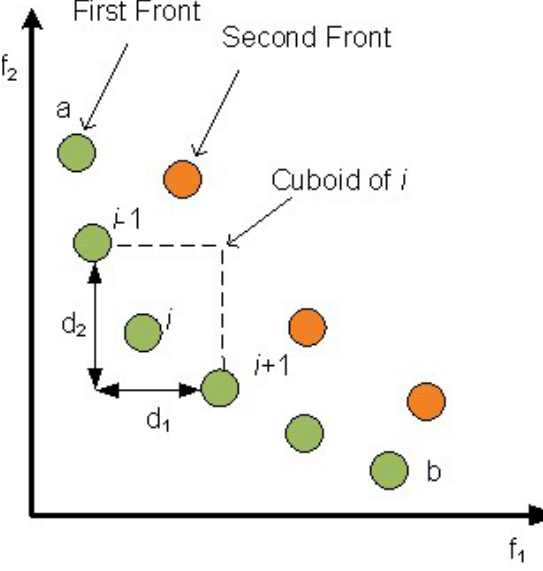
Fig. 6. Diagram of crowding distance